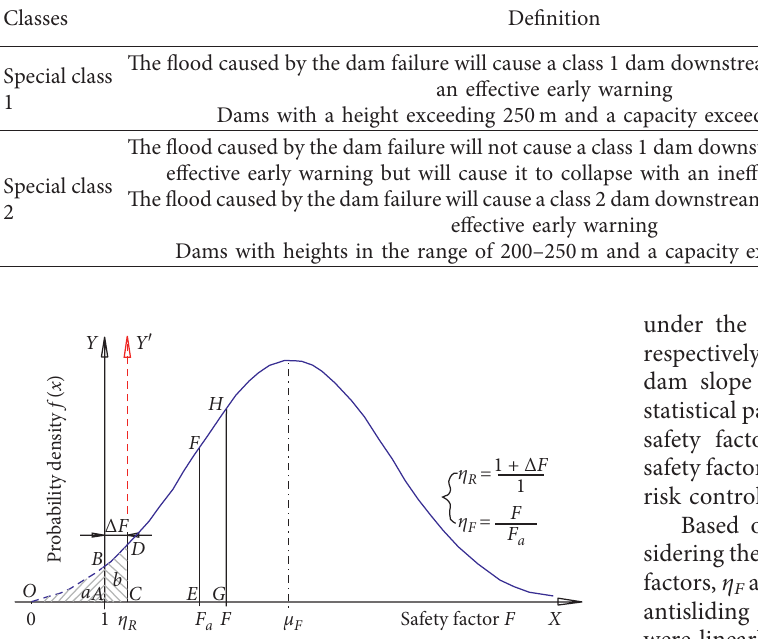
F based on the probability density